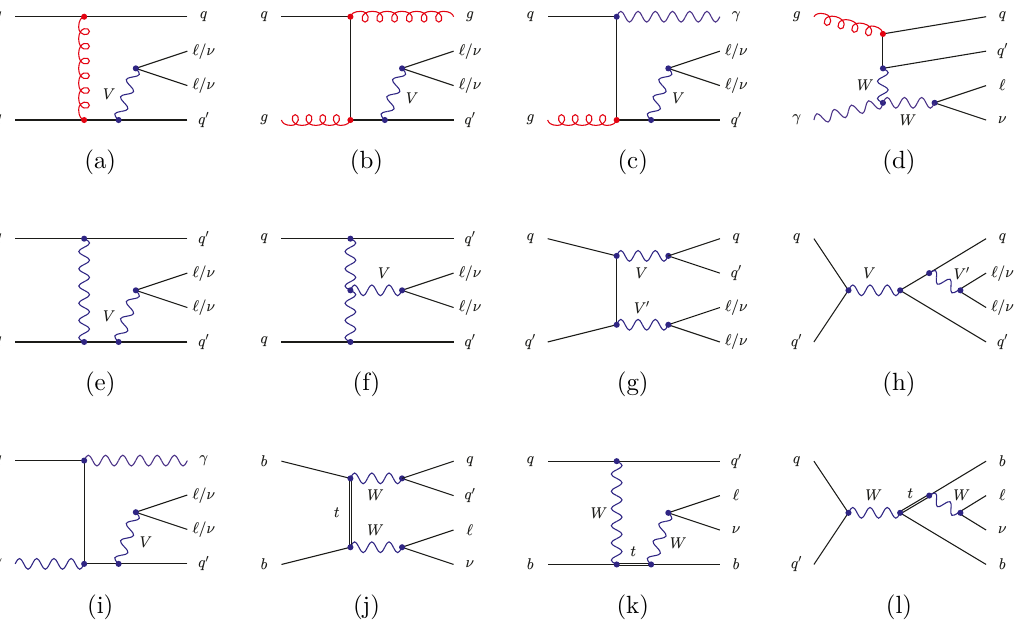
Figure 2. Example LO diagrams at O ( g 2 e 2 ) (a,b), O ( g s e 3 ) (c,d), and O ( e 4 ) (e-l). The square of s O ( g 2 e 2 ) diagrams yields the O ( α 2 α 2 ) QCD LO amplitude, while the square of the O ( e 4 ) diagrams s s yields the O ( α 4 ) EW LO amplitude. The O ( α s α 3 ) perturbative contribution emerges as square of O ( g s e 3 ) diagrams, or due to the interference between O ( g 2 e 2 ) and O ( e 4 ) s